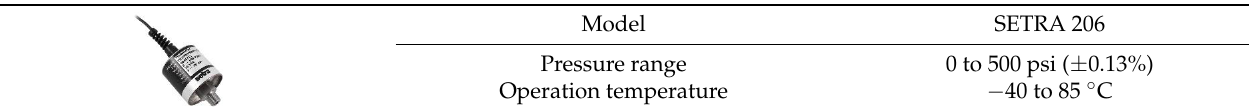
Table 10. Pressure sensor specification.